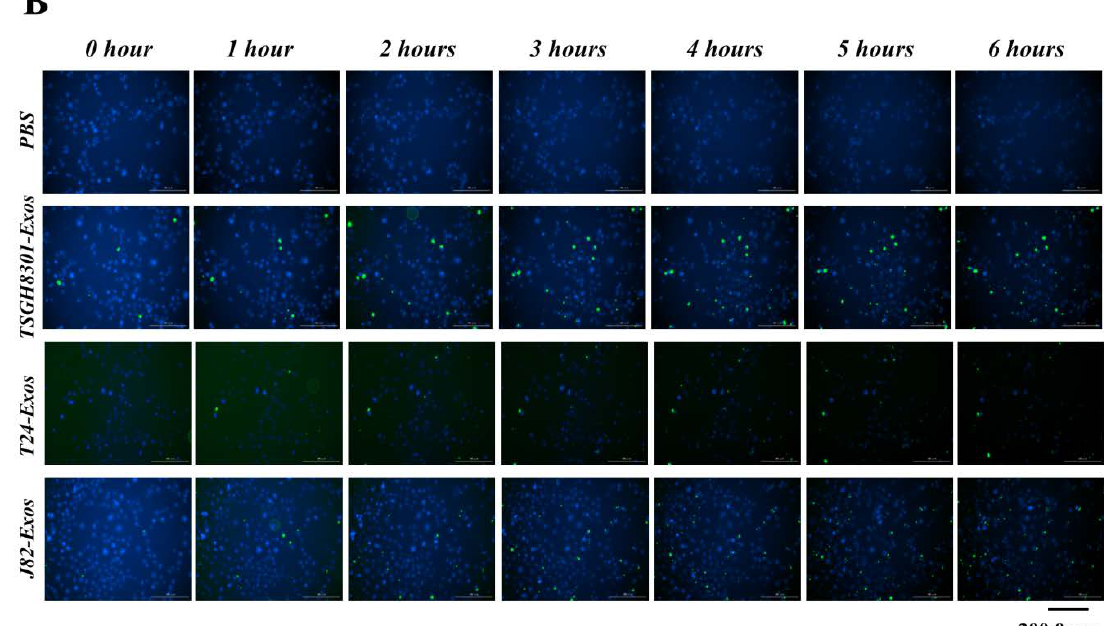
Figure 2. Exosomes serve as a mediator in intercellular communication. Exosomes derived from bladder cancer cells were labeled with FITC-conjugated anti-CD9 antibody (green) and counterstained with Hoechst 33342 (blue) for 24 h, and exosomes uptake was observed under a BioTek LIONheart FX microscope ( A ) for different spectra, and ( B ) merged figures were aligned upon different time points.